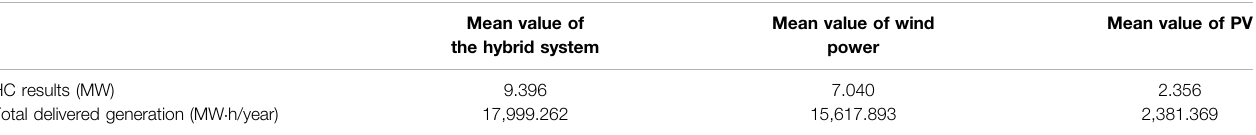
TABLE 5 | Mean values of the hosting capacity and delivered